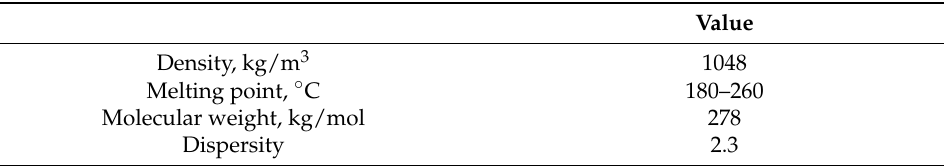
Table 1. PS properties.